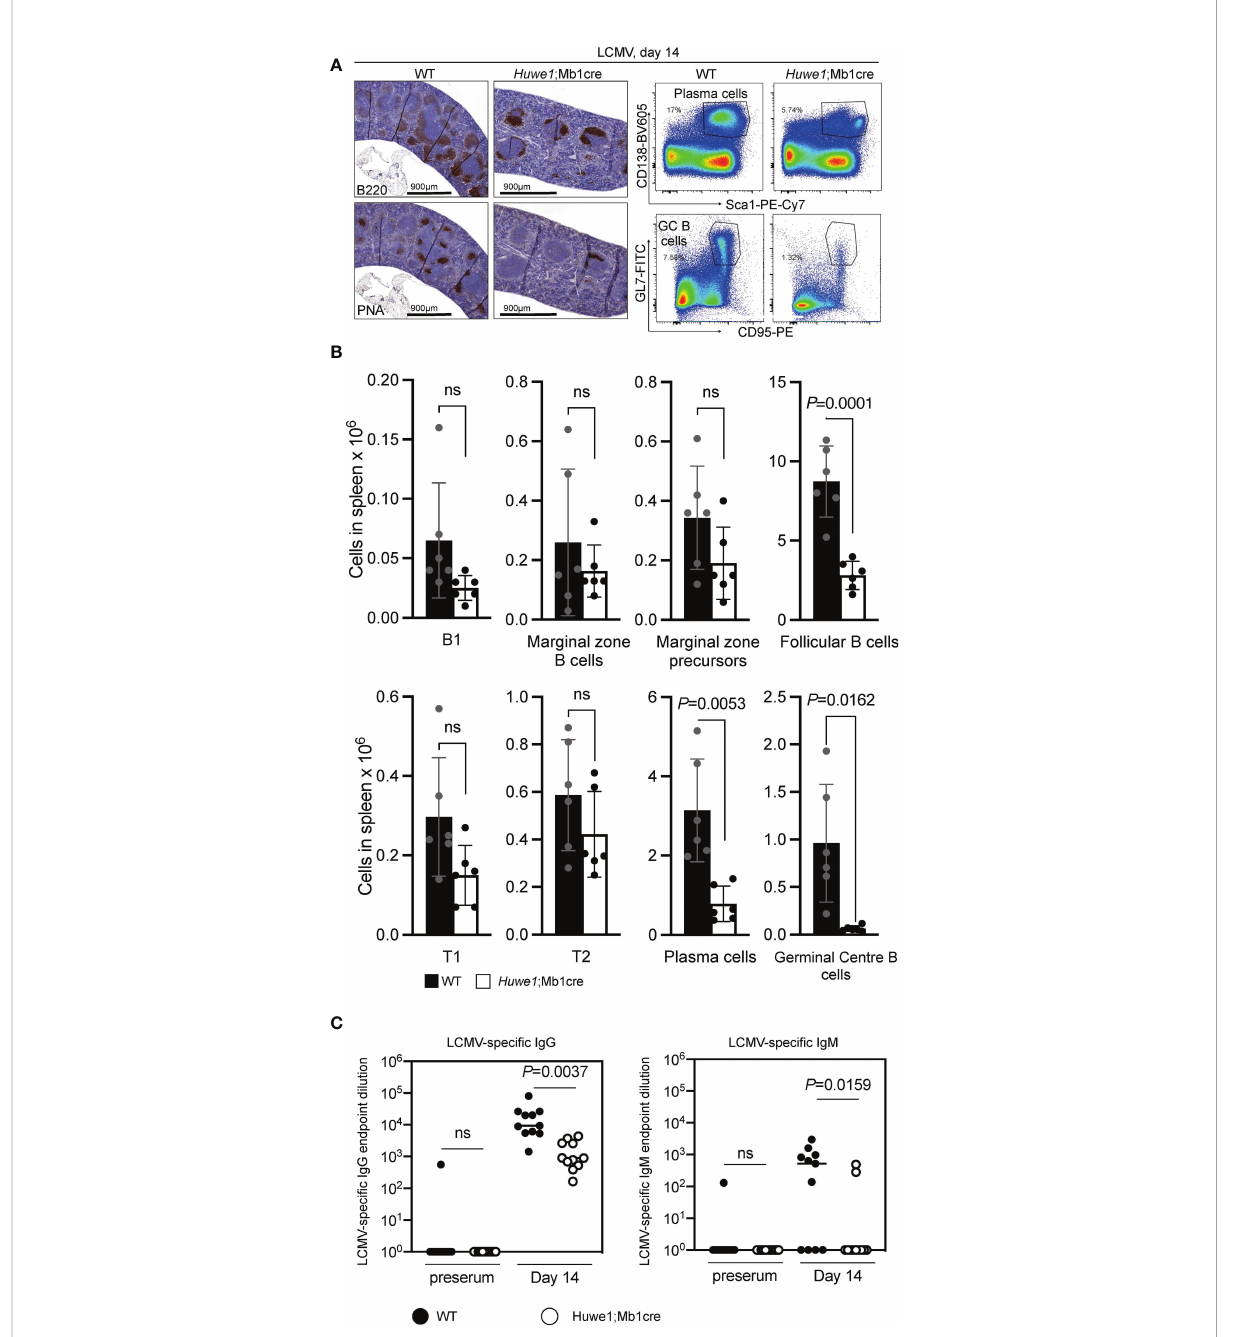
FIGURE 2 Huwe1-de fi ciency reduces the immune response to lymphocytic choriomeningitis virus. (LCMV). Wildtype (WT) and Huwe1;Mb1cre mice were infected with LCMV and analyzed 14 days post-infection. (A) Left panels show immunohistochemistry for B220 (total B cells) and peanut- agglutinin (PNA) (GCs). Right panels show fl ow cytometry gating strategy for plasma cells (CD138+ Sca1+) and GC B cells (GL7+ CD95+) in spleens from LCMV-infected mice. Percentage of gated cells are indicated. (B) Absolute numbers of indicated B-cell subsets from LCMV- infected spleens. Means ± SD are depicted. Black bars represent WT mice, white bars represent Huwe1;Mb1cre mice (N=6 for both groups). Flow cytometry gating strategy for B-cell subsets was similar as in Figure 1. (C) LCMV-speci fi c IgG and IgM serum titres 14 days post-infection. Serum isolated before infection (preserum) was used as control. Numbers indicate the endpoint dilution of the sera. N=12 for both groups. P- values were calculated using an unpaired t-test with Welch correction. ns, not signi fi